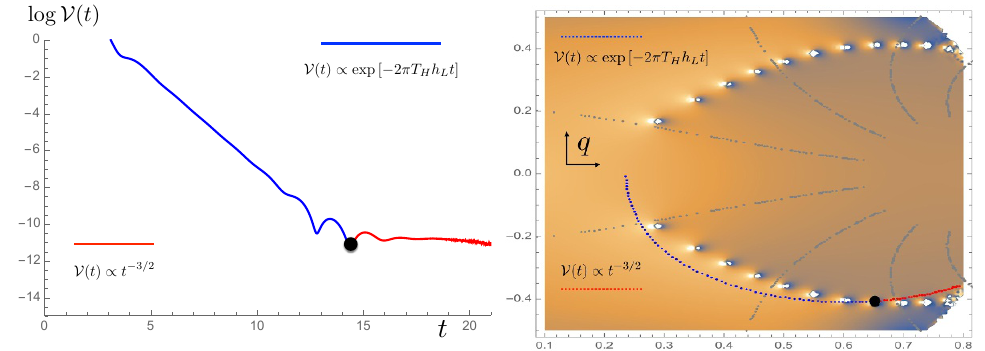
Figure 23 . Left: real-time behavior of the vacuum block, with a marked late-time transition from thermal exponential decay to a power-law behavior. Right: corresponding trajectory q ( t ) on q -plane (blue and red dashed lines) with transition point marked, against the density plot of the accessory parameter p vac ( q ), gray lines are the physical branch-cuts at x = 1. Transition point coincides with the intersction between q ( t ) and the resolved branch-cut, which is now a string of poles (zeros) in p vac ( q )( ( q )). Parameters used: c = 30 ; h H = 5 ; h L = 1 = V vac